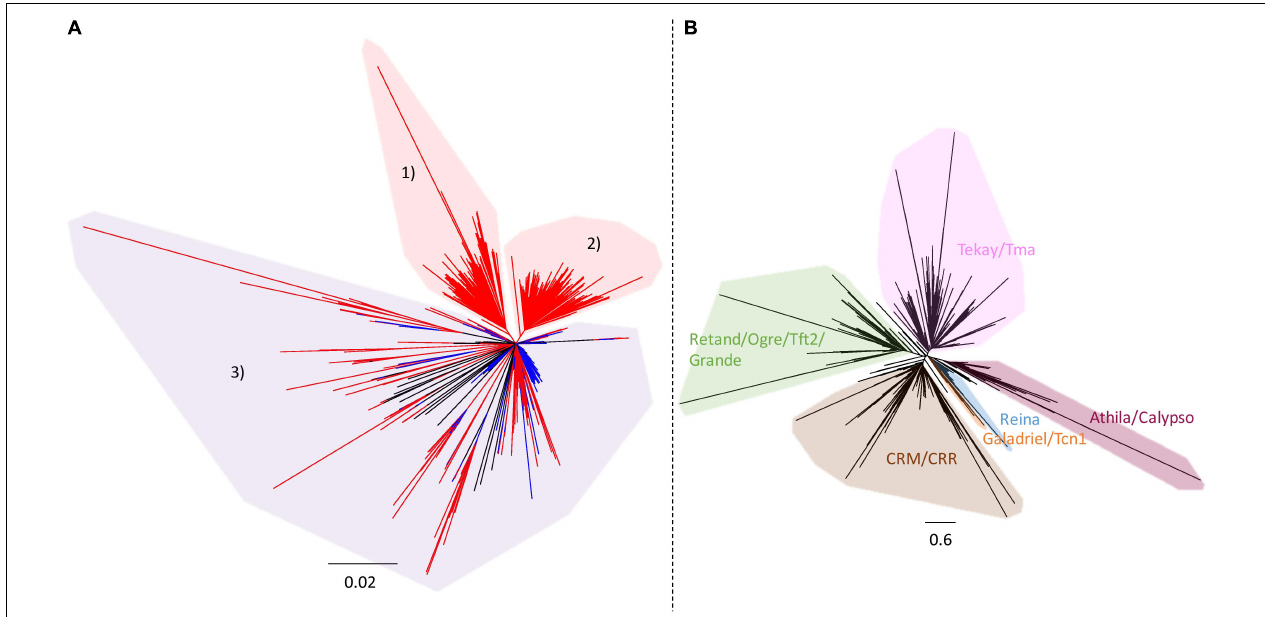
FIGURE 4 | (A) Neighbor-joining phylogram of the rDNA of 168 B. rapa ‘Chiifu’ sequences (in blue) and 271 B. rapa ‘Z1’ sequences (in red). Clades 1 and 2 in red included only ‘Z1’ sequences. Clade 3 in purple included ‘Chiifu’ and ‘Z1’ sequences. (B) Neighbor-joining phylogram and classification of LTR gypsy elements of 2,447 B. rapa ‘Chiifu’ sequences, 2,908 B. rapa ‘Z1’ sequences and 60 gypsy sequences from the gypsy database for identifying major clades of